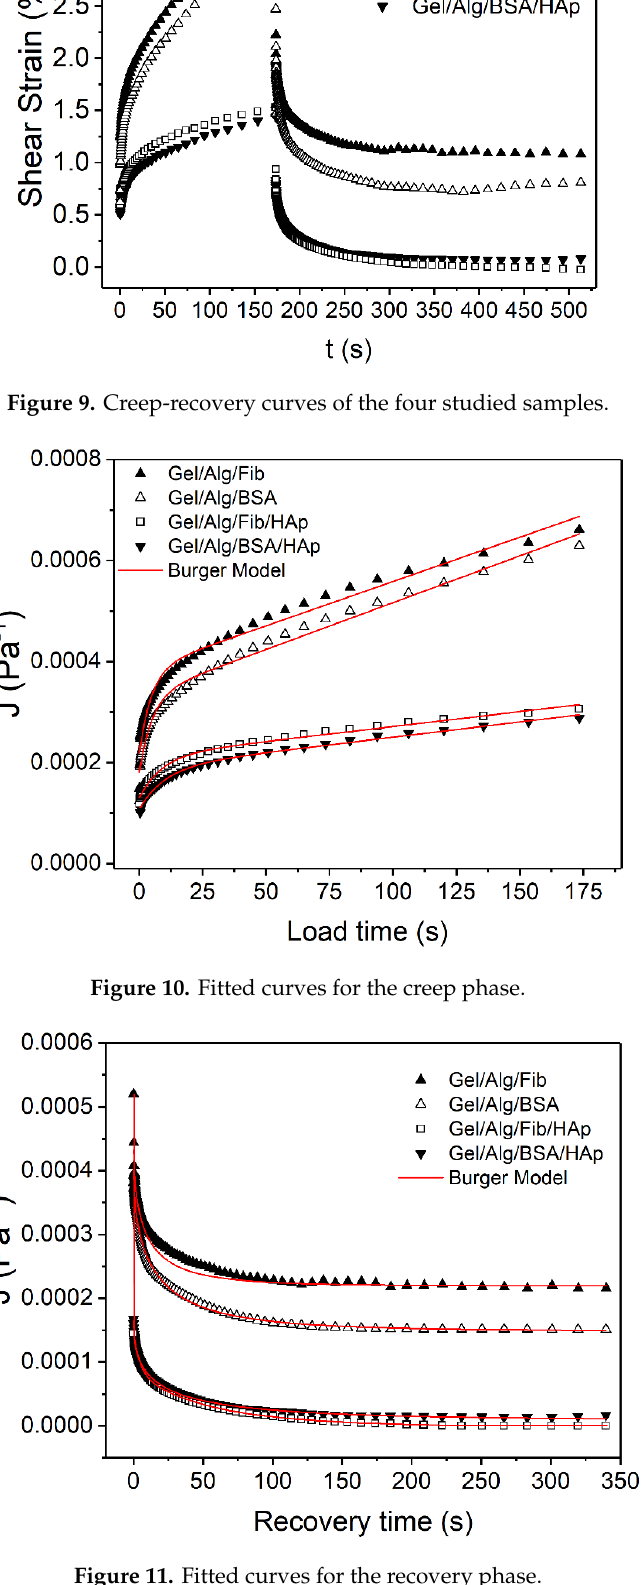
Figure 11. Fitted curves for the recovery phase.